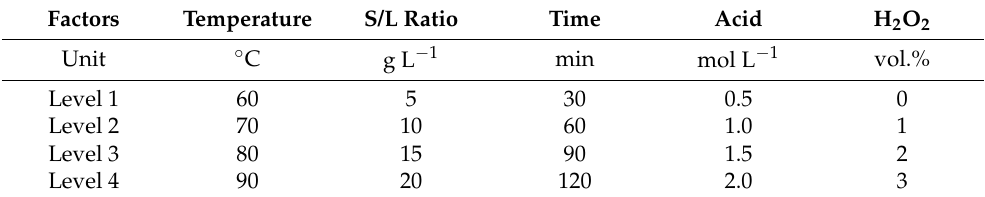
Table 2. Control factors and selection levels.